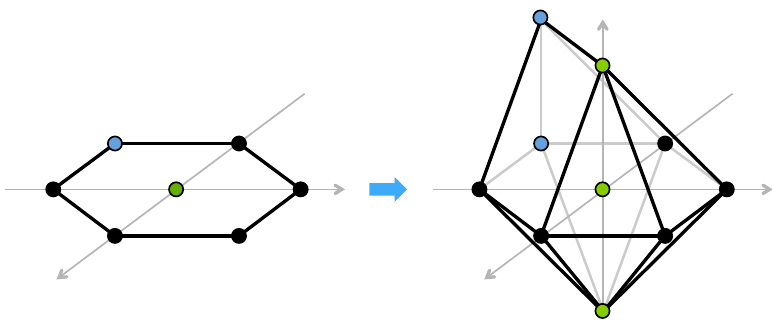
Figure 1. Example of lift of two points in the toric diagram of the complex cone over dP 3